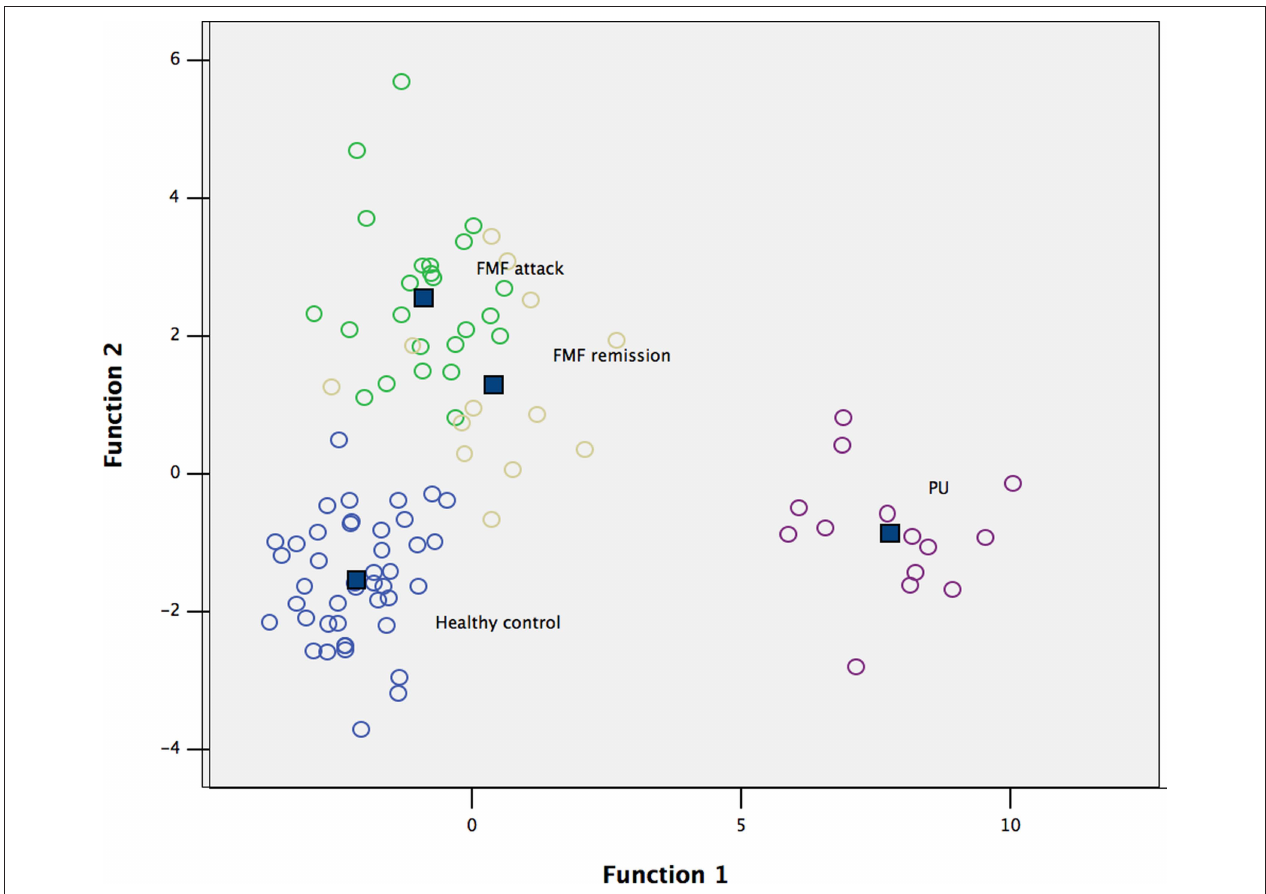
FiGUre 1 | Scatterplot of da model based on concentration of fatty acids and phenolics in blood. Number of variables in model: 35; grouping – 4 groups. Root 1, 2 – discriminant functions 1 and 2 (first and second canonical roots). Healthy controls are shown in blue circles; FMF attack – in green circles; FMF remission – in yellow circles; and PU – in purple circles. Class centers are shown in dark blue